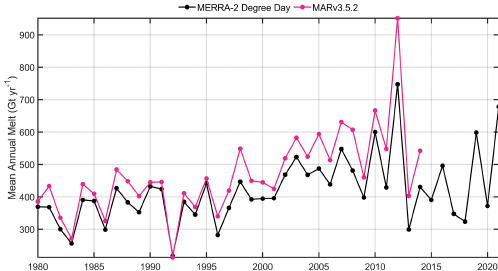
Figure 22. Comparison of annual melt from the MERRA-2 degree- day model (Sect. 2.2.1) and MARv3.5.2, the model used to train the degree-day model (Fettweis et al.,